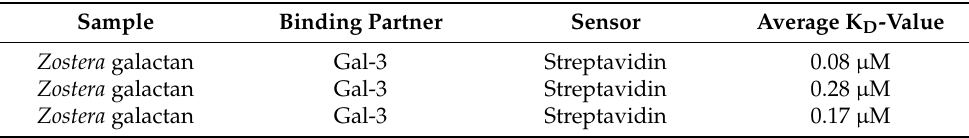
Figure 6. Results of BLI-experiments of Zostera galactan to Gal-3 (streptavidin sensors). Table 4. Binding parameters of Gal-3 with Zostera galactan determined by BLI. The average K D -values are calculated from the results of the four different concentrations for each experimental